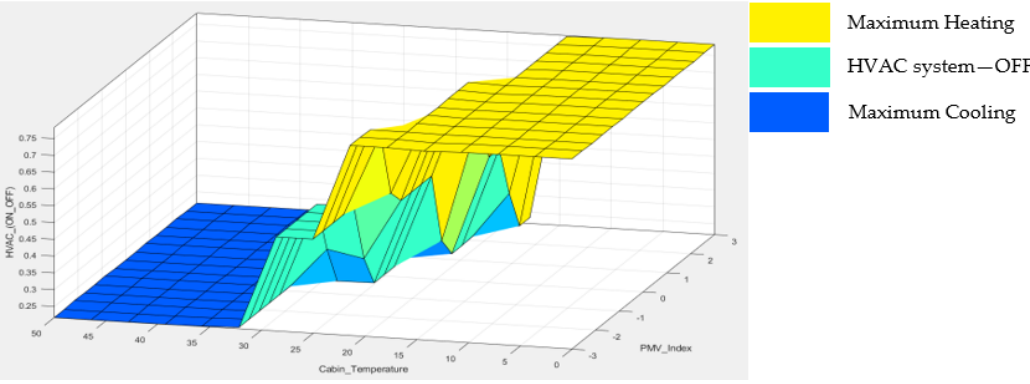
Figure A2. Fuzzy logic membership function of the PMV index and CO 2 concentration designed to regulate the HVAC system recirculation flap. Figure A2 illustrates the mapping of the PMV index and CO 2 concentration to control the recirculation flap of the vehicle HVAC system through fuzzy rules. As described in